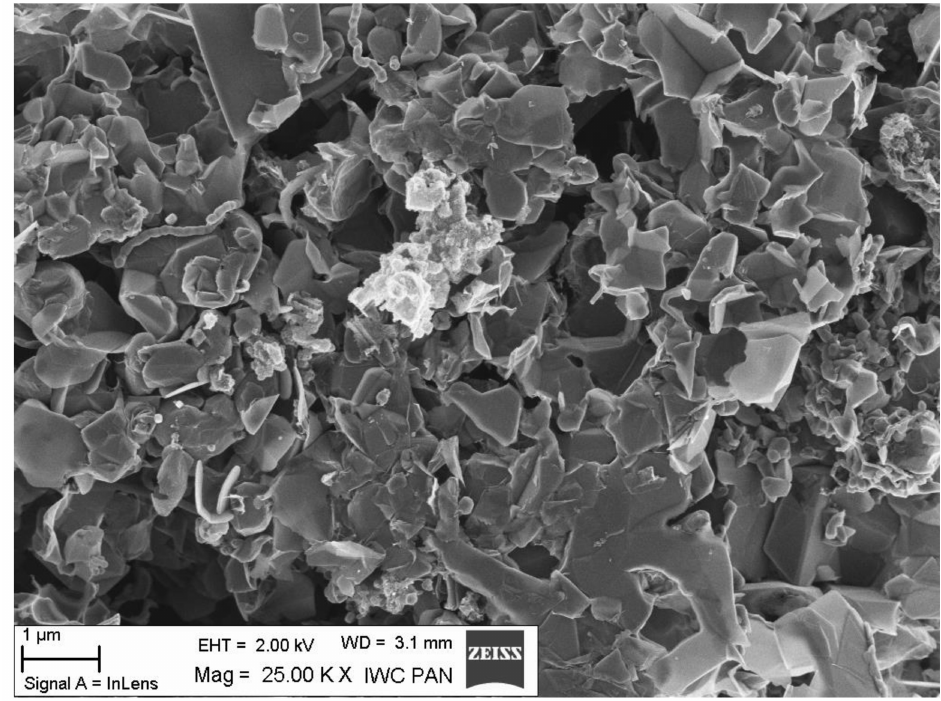
Figure 6. SEM image of carbon material C-AO obtained from (NH 4 ) 2 C 2 O 4 . 3.2. Influence of the CPE Modifier on the Voltammetric Measurements Results Differential pulse voltammograms (DPV) for the modified CPEs as an example with 0.5 mmol/L 4-CP solutions are shown in Figure